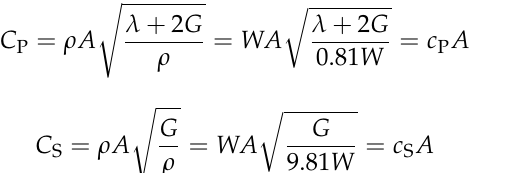
Figure 7. Peak acceleration at different locations of the tunnel lining (A7~A10). It can be seen from Figure 6 that the numerical calculation results and the model test results are close and the peak accelerations at the ground surface are all maximum values, all of which exceed 225 mm·s − 2 . With the increase in the distance from the ground surface, the peak acceleration of the foundation under vibration load decreases continuously,